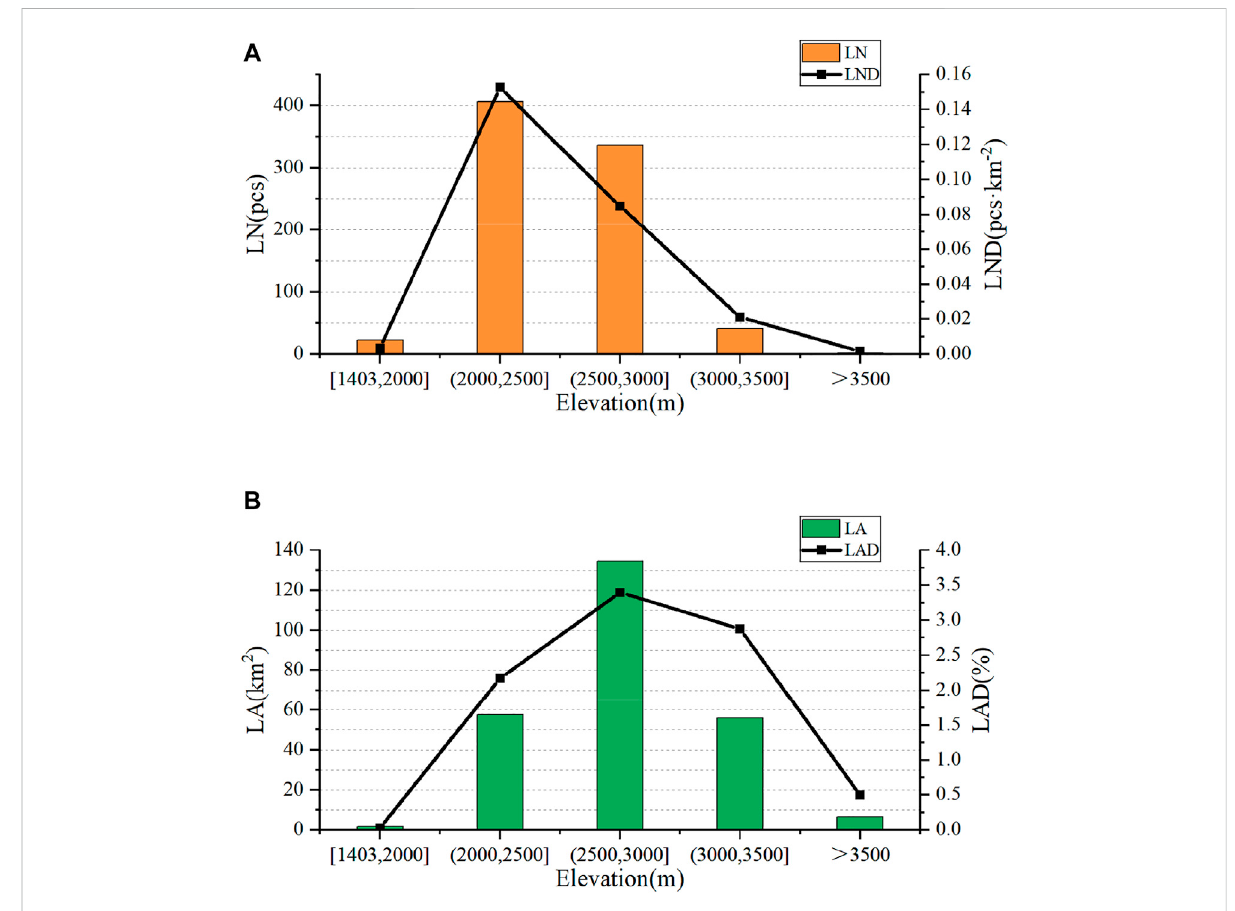
FIGURE 6 The correlations between elevation and landslide distribution. (A) LN and LND; (B) LA and